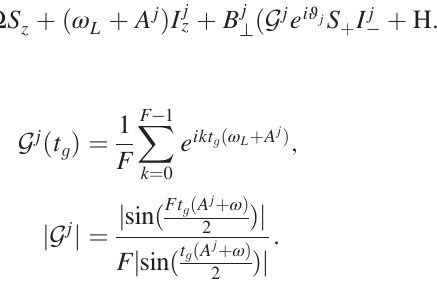
FIG. 3. Protocol for quantum-enhanced nuclear spin